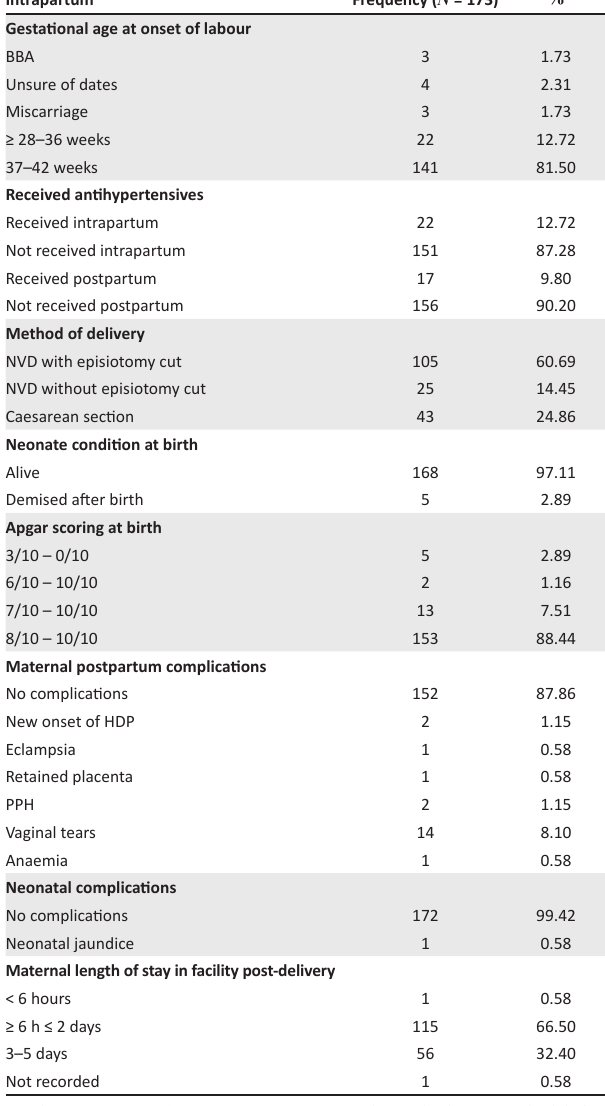
TABLE 3: Intrapartum and postpartum care and